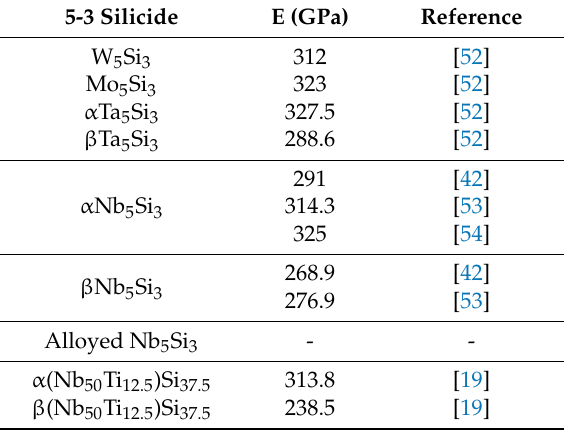
Table 3. Calculated elastic moduli of TM 5 Si 3 silicides and Nb 5 Si 3 alloyed with